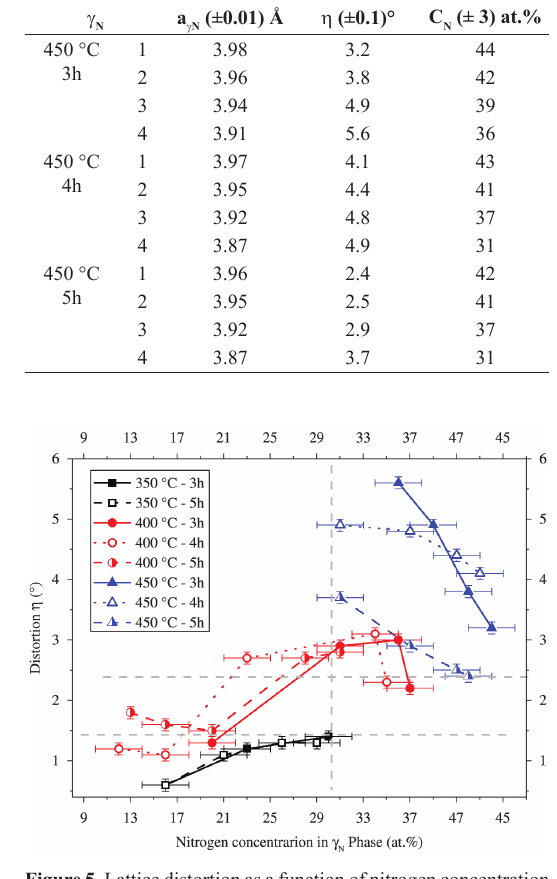
Figure 5. Lattice distortion as a function of nitrogen concentration phases used in DRX patterns fittings, for each sublayer of the g N for all the nitrided samples.